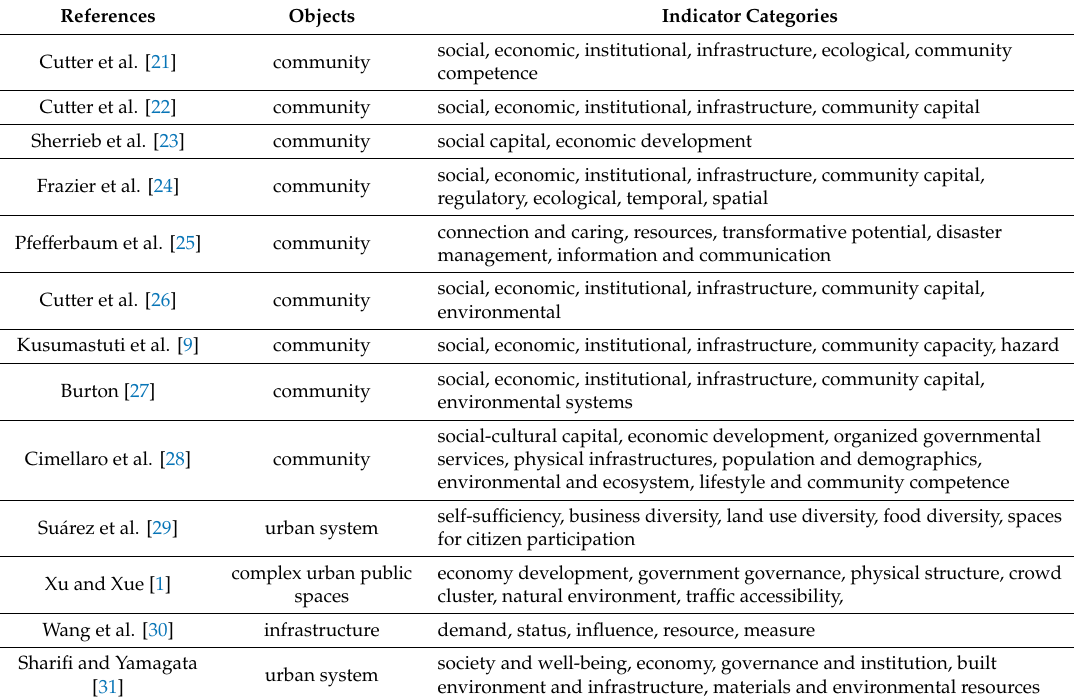
Table 1. Resilience assessment